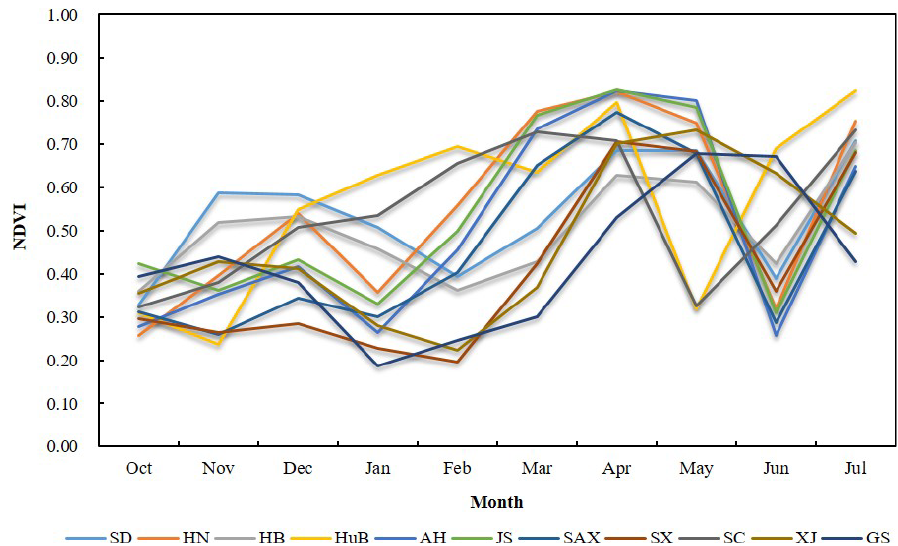
Figure 4. Seasonal changes of NDVI for winter wheat over 11 provinces in the study